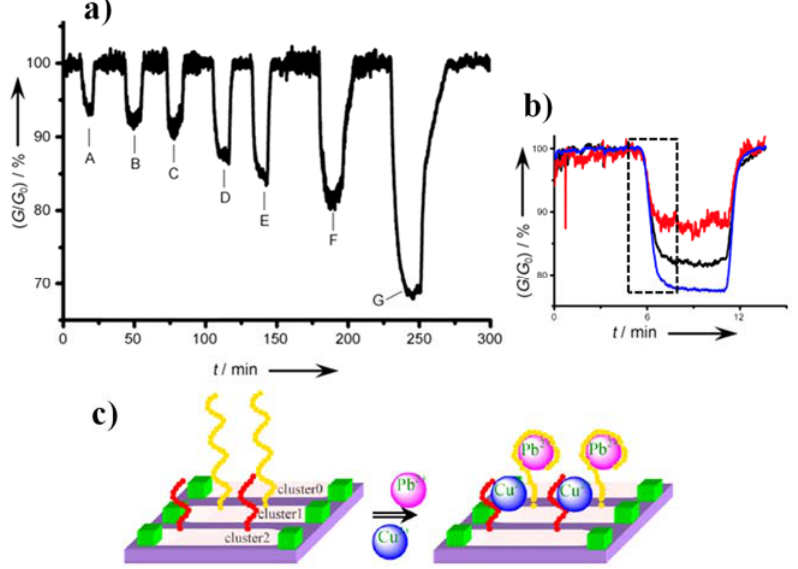
Figure 9. Example of SiNW FET sensor in environmental monitoring. ( a ) Response of an APTES ‐ functionalized p ‐ type SiNW FET when exposed to different concentrations of TNT of and a reference solution: (A) 500 fM; (B) 5 pM; (C) 5 nM; (D) 75 nM; (E) 100 nM; (F) 500 nM; and (G) 5 mM. ( b ) Real ‐ time measurement of TNT (5 μ M) in 0.1% DMSO/H 2 O solution in three different devices (black, red and blue curve). The decrease and increase of the nanowire conductance are regulated by adding TNT and reference solution, respectively. The black dash box indicates the time to reach the sensing plateau. Reprinted with permission from Ref. [177], Copyright (2010), Wiley. ( c ) SiNW FETs for the detection of heavy metals through oligopeptide clusters: Cluster 0, aldehyde modified SiNWs; Cluster 1, oligopeptides specific for Pb 2+ ; and Cluster 2, oligopeptides specific for Cu 2+ . Reprinted with permission from Ref. [180], Copyright (2009), Elsevier.